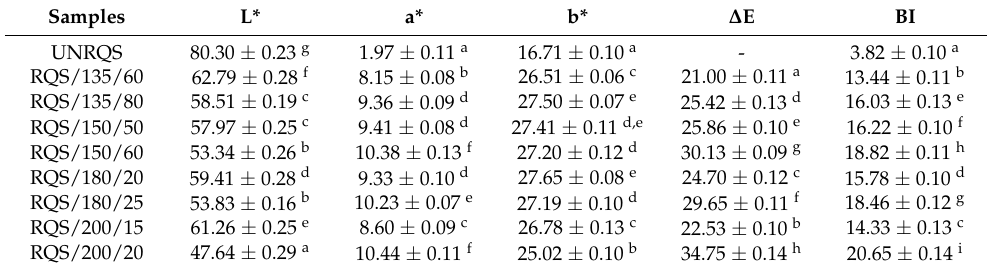
Table 2. CIE L*a*b* color parameters and browning index of Q. rubra seeds before and after